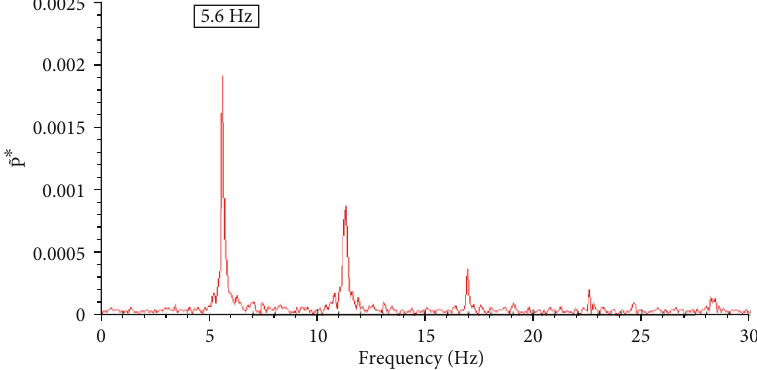
Figure 8: Spectrum analysis of the total pressure signal during the fully developed phase of the stall